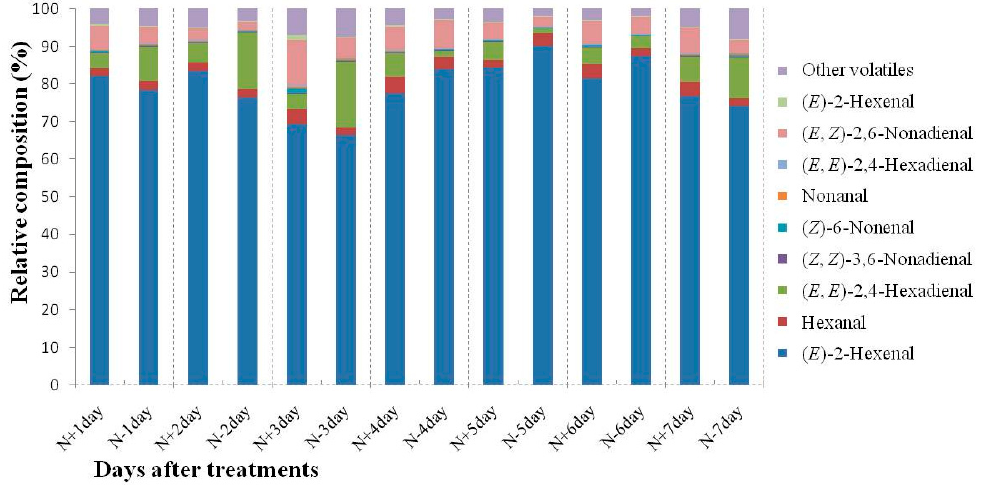
Figure 3. Relative composition (%) of volatiles from 9930 leaves of N-sufficient and deficient treatments. N+ and N − mean nitrogen su ffi cient and nitrogen de fi cient treatments, respectively. N+ and N − mean nitrogen sufficient and nitrogen deficient treatments, respectively. Values are means Values are means of three replicates. of three